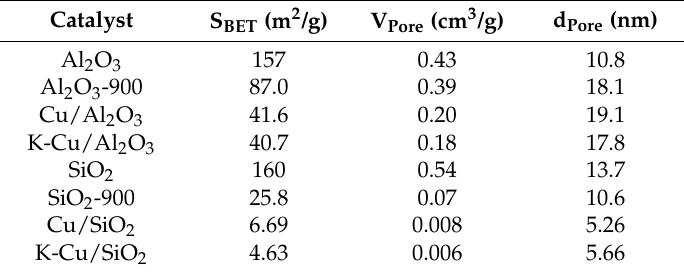
Table 1. Textural properties of the representative